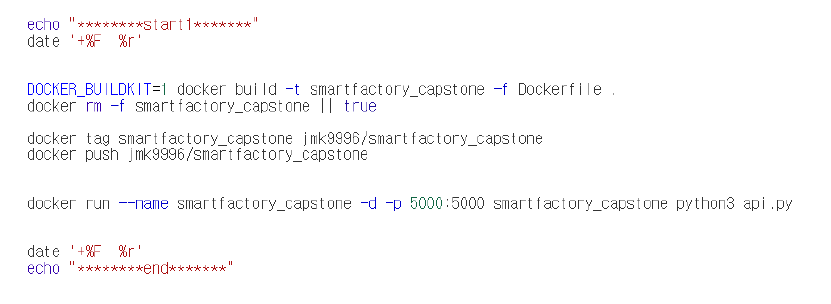
Figure 7. Automation job list and the time duration of number of builds.